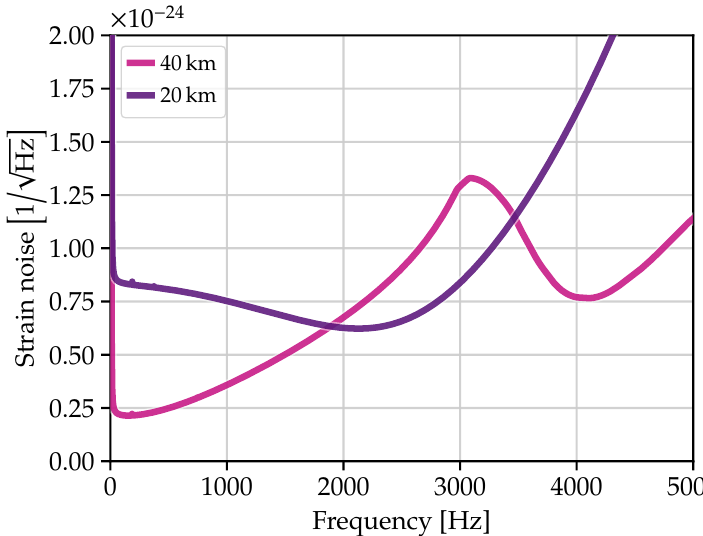
Figure 6. Comparison of a broadband 40km Cosmic Explorer observatory and a 20km kilohertz- optimized observatory (Section